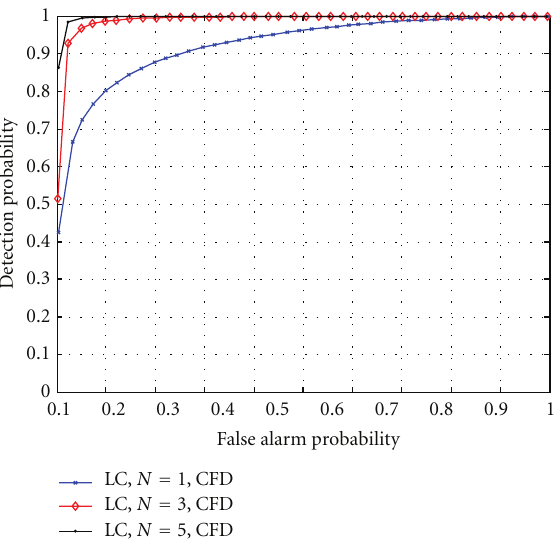
Figure 9: ROC curves of cyclostationary-based linear classifier scheme: SNR avg = − 14dB and M =